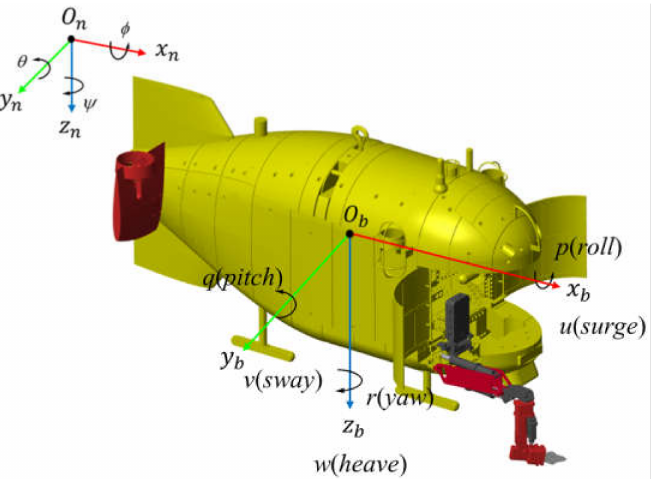
Figure 1. The Haidou-1 ARV and its reference